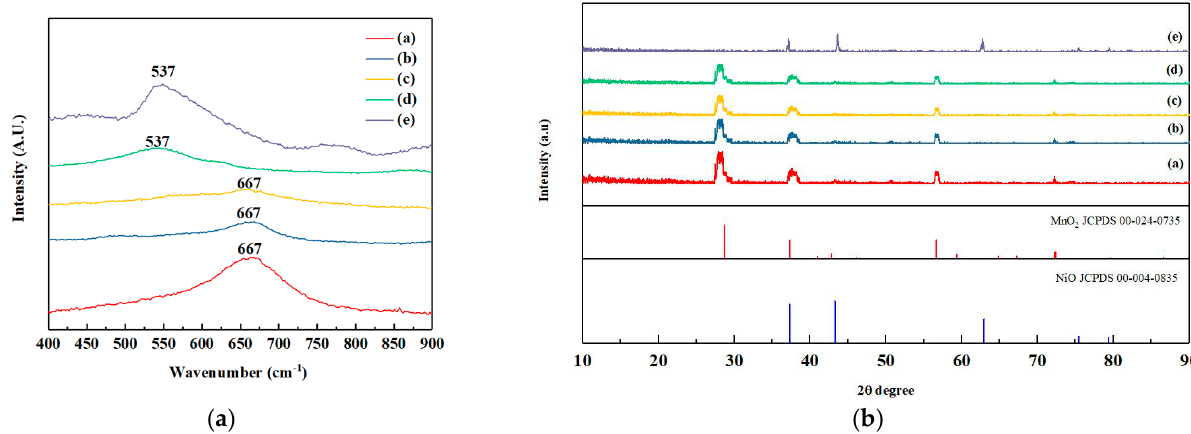
Figure 1. ( a ) Raman and ( b ) XRD of the Mn-Ni-O electrodes. Samples (a), (b), (c), (d), and (e) denote the samples with electroplating Mn: Ni ratio of 1:0, 1:0.25, 1:0.67, 1:4, and 0:1 respectively.